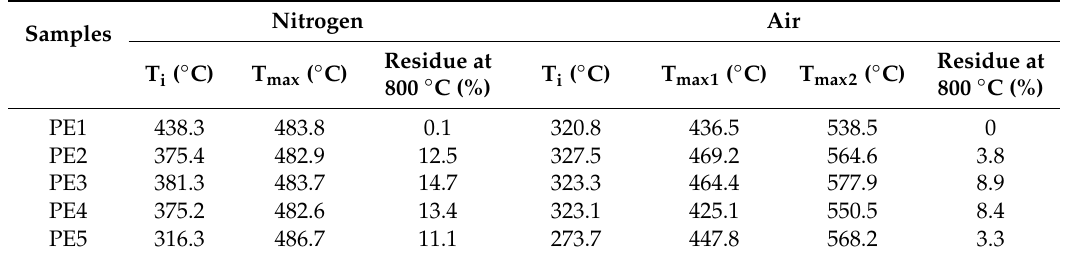
Figure 8. ( a ) TGA and ( b ) DTG curves of HDPE and HDPE / IFR composites in nitrogen atmosphere. Table 5. TGA and DTG data of HDPE and HDPE / IFR composites in nitrogen and air